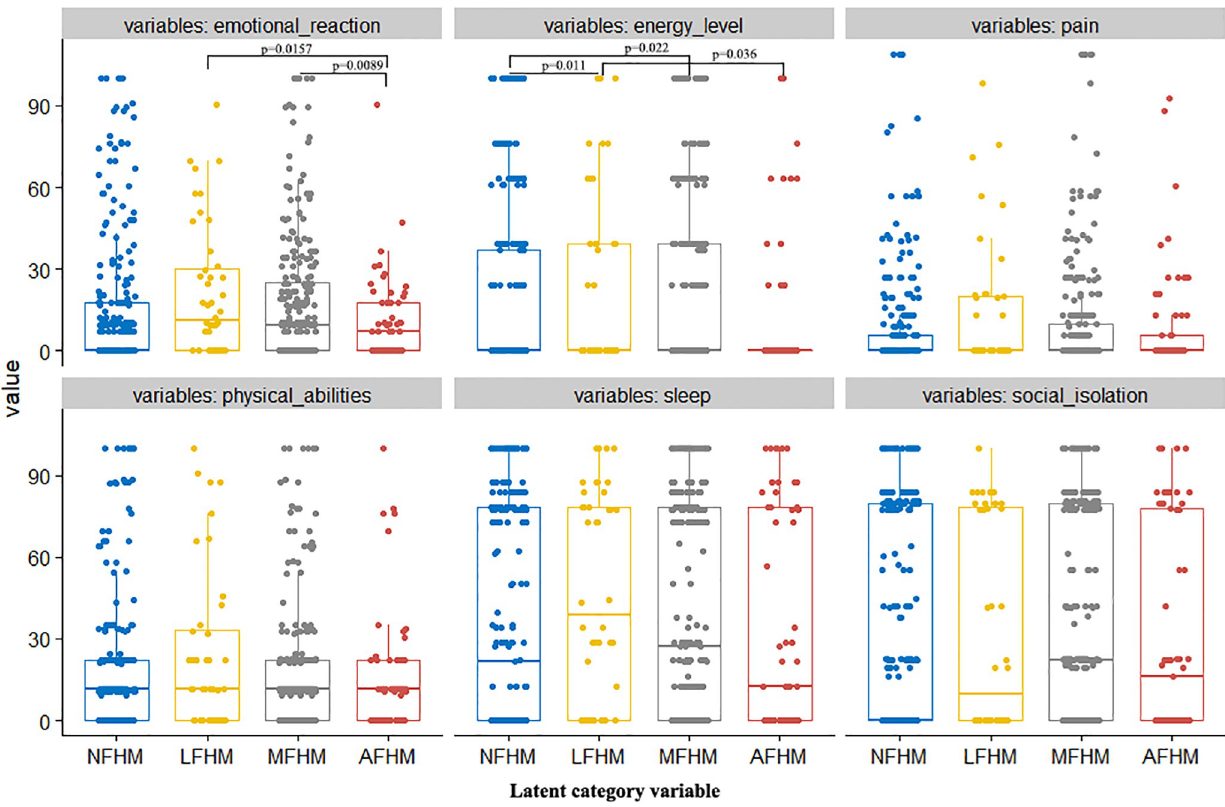
Fig 6. Effects of different latent FHM (family health management) modes on individual health status.